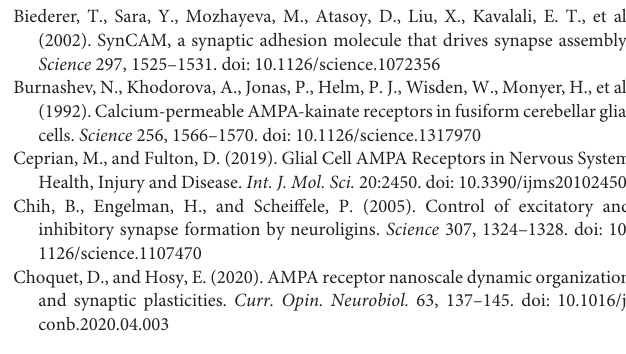
Supplementary Figure 1 | Validation of co-expression of myc-tagged LRRTM2 and EGFP in transfected astrocytes. Standard cultures of astrocytes without explants were co-transfected with EGFP and myc-LRRTM2 plasmids. (A,C) Co-expression of EGFP and myc-tagged LRRTM2 in cultured cortical (A) and cerebellar (C) astrocytes was confirmed by EGFP fluorescence (EGFP) and by immunocytochemical staining with myc-antibodies (myc). Overlay of images (merge) to demonstrate co-expression. (B,D) Control experiments, in which cultured cortical (B) and cerebellar (D) astrocytes were only transfected with EGFP, did not exhibit any myc fluorescence signal. Supplementary Figure 2 | Quantitative analysis of vGlut1-immunopositive puncta area. (A,D) Merged images of vGlut1 (red) and GFAP (green) immunofluorescence of an immature cortical astrocyte innervated by explant fibers (A) and of a cerebellar astrocyte innervated by explant fibers (D) . The astrocyte is outlined in red. The blue square demarcates the area in which vGlut1 puncta on explant fibers were analyzed at 12 days in co-culture. Scale bars: 10 µ m. (B,E) Negative images of vGlut1 immunofluorescence that were thresholded to obtain the images shown in (C,F) . (C,F) Astrocyte outline (red) and explant fiber area (blue) were transferred onto thresholded negative images of vGlut1 immunofluorescence. Regions of interest (ROIs) were created around black puncta, and puncta area was determined separately for astrocytes (red outline) and explant fibers (blue square). ImageJ software was used for image